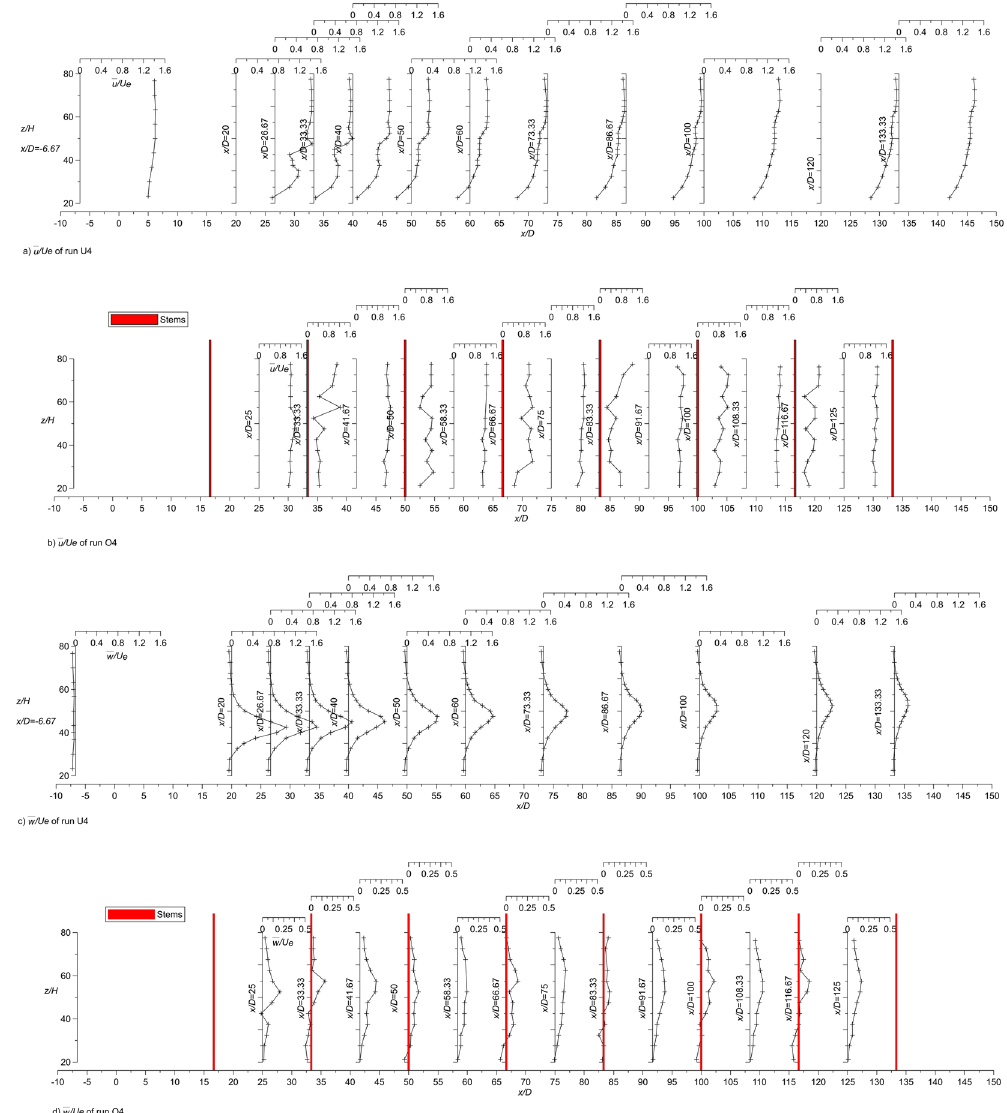
Figure 3. Longitudinal profiles of the dimensionless time-averaged streamwise u and vertical w velocity components of runs U4 and